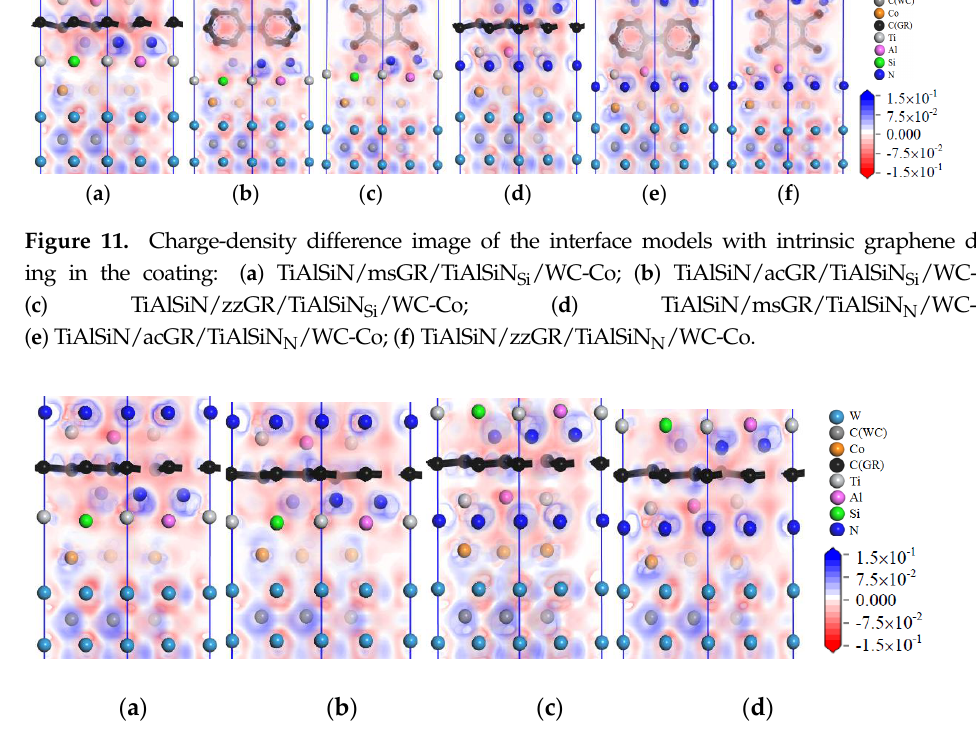
Figure 12. Charge-density difference of interface models that the coating is doped with defective graphene: ( a ) TiAlSiN/svGR/TiAlSiN Si /WC-Co; ( b ) TiAlSiN/tdGR/TiAlSiN Si /WC-Co; ( c ) TiAlSiN/svGR/TiAlSiN N /WC-Co; ( d ) TiAlSiN/tdGR/TiAlSiN N /WC-Co.